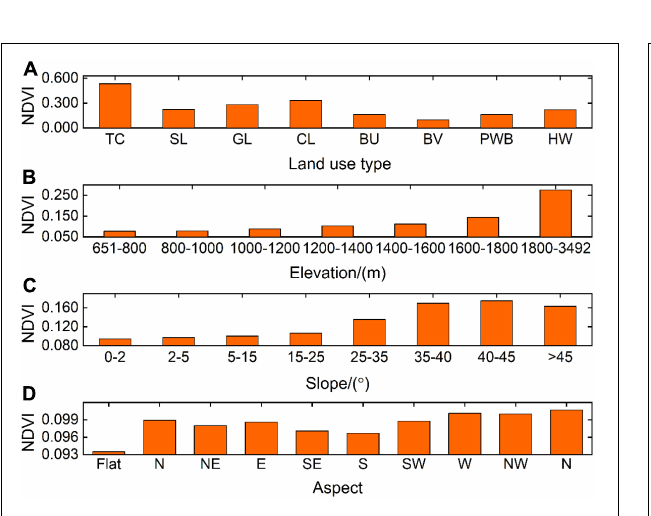
FIGURE 4 | Pie chart of NDVI value and its change trend and the proportion of significant spatial distribution change.